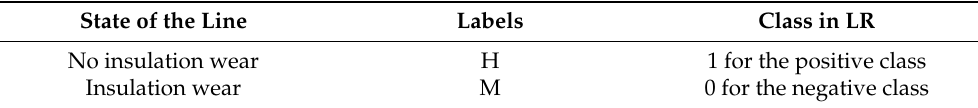
Table 2. Analogy between labels and classes. State of the Line